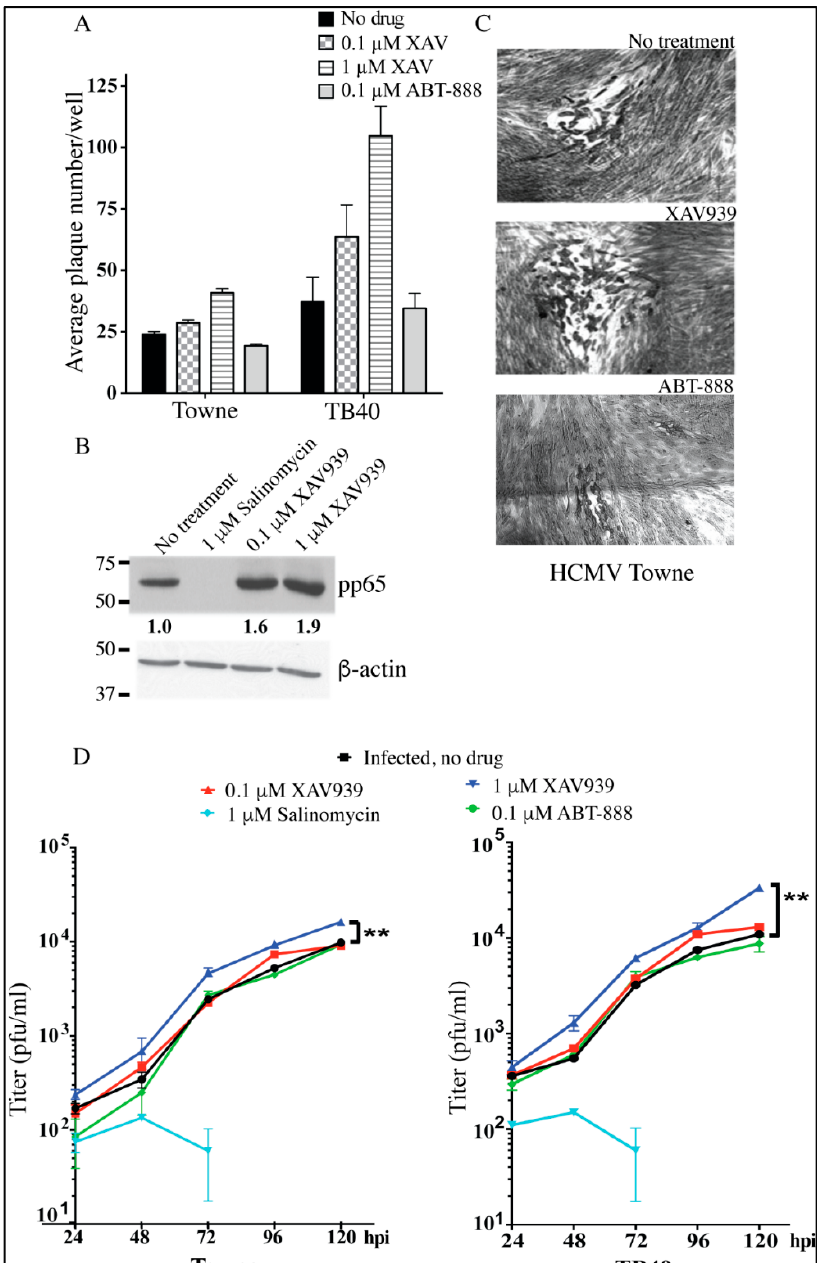
Figure 4. TNKS inhibition favors HCMV replication. ( A ) Plaque assay for HCMV Towne and TB40 strains with XAV939 (PARP5 inhibitor), and ABT-888 (PARP1and 2 inhibitor). HFFs were infected to yield approximately 50-100 plaques/well, stained and quantified at 10 days after plating; ( B ) Western blot to detect viral proteins at 72 hpi in HFFs infected with HCMV Towne at MOI = 1. Fold change in protein expression normalized to β -actin are quantified under the blot; ( C ) Plaques from ( A ) imaged after staining at 10× magnification; ( D ) Viral growth assay for Towne and TB40 strains with XAV939 (PARP5 inhibitor), Salinomycin (Wnt inhibitor) and ABT-888 (PARP1and 2 inhibitor). HFFs were infected and supernatants were collected at 24-h intervals till 120 hpi. Released virions were titered by a standard plaque assay. Average pfu/mL calculated from quadruplicate wells of one experiment are shown. * indicates p value < 0.05, ** indicates p < 0.01.